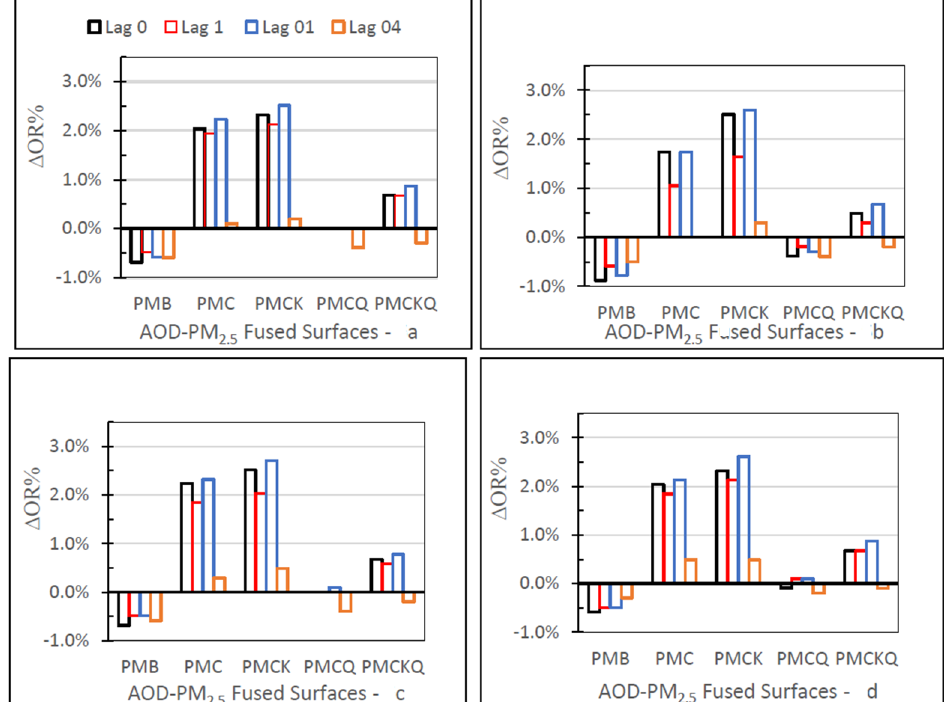
Figure 6. The no monitor–monitor OR percent ( ∆ OR%) values for the four AOD-PM 2.5 and baseline PMB fused surfaces for lag grids 0, 1, 01, and 04, and in separate panels for ED asthma ( a ), IP asthma ( b ), IP MI ( c ), and IP HF ( d ).